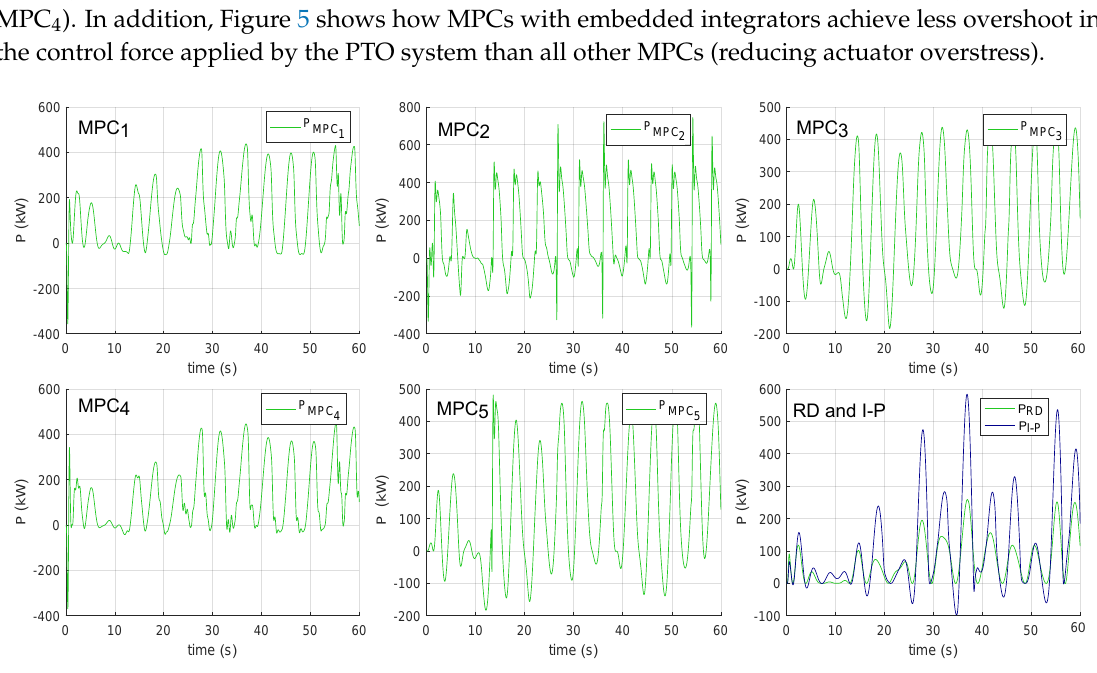
Figure 4. Simulation of the instantaneous mechanical powers generated by the WEC system when applying the seven controllers to the mathematical model (15). Table 4. Control parameter set for the sea state defined by the JONSWAP spectrum (3 m of significant wave height and 11 s of peak